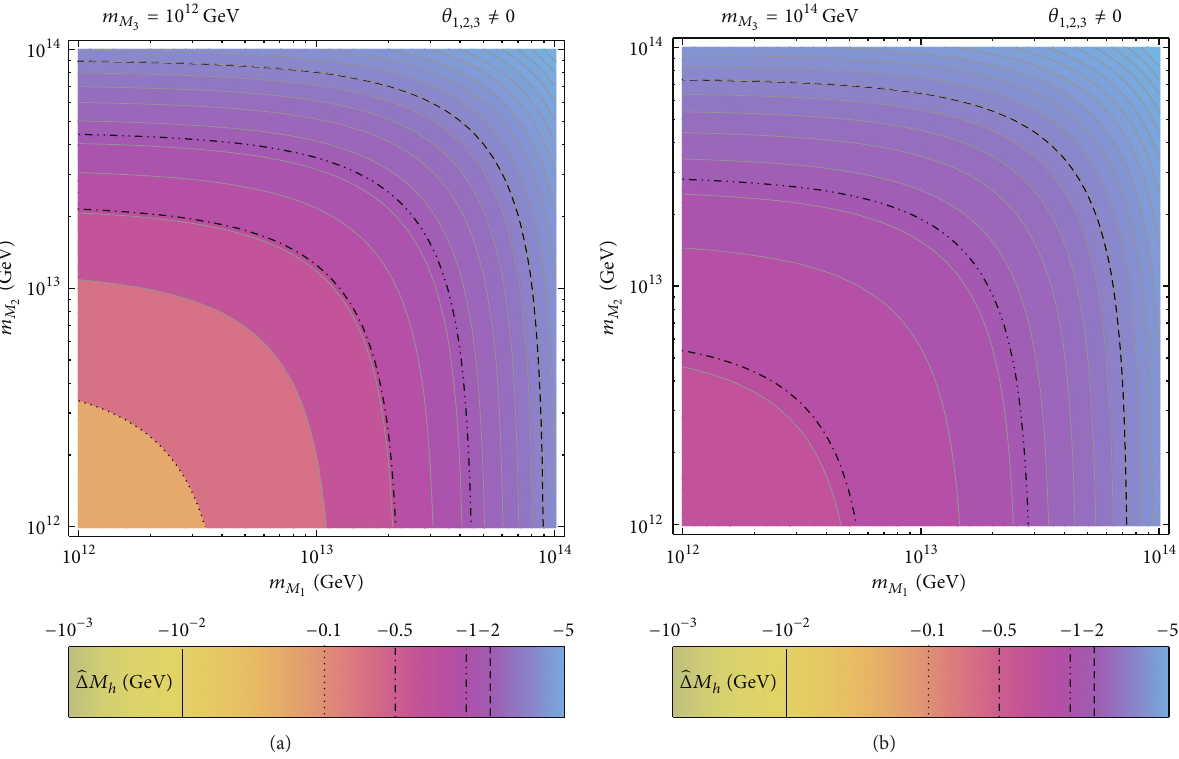
̂Δ𝑀 ℎ contour lines in the ( = 3 𝜋/ 4 𝑒 𝑖𝜋/ 7 . (a) 𝑚 3